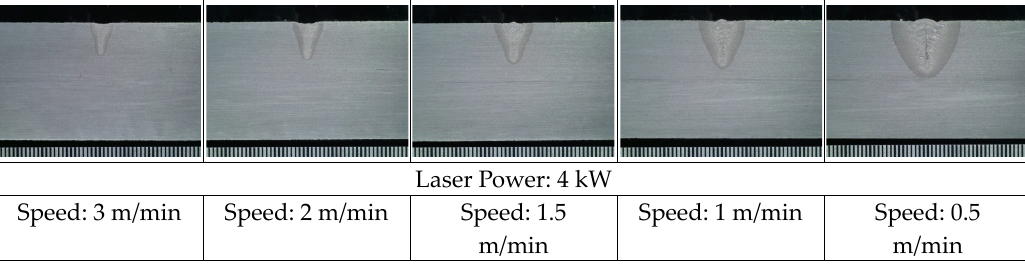
Figure 6. Bead geometry on BOP welding test (laser power: 4 kW).